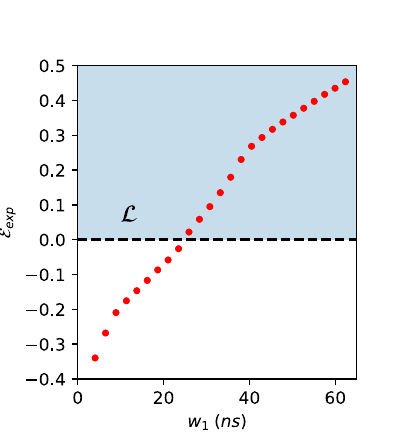
Fig. 9 | Robustness of the entropic technique to experimental noise. Values of the quantity E exp , as de fi ned in Eq. (8), as function of the two-fold coincidence window w 1 . If w 1 >25ns, due to the noise, the entropic witness isnot ableto detect nonclassicality, resulting in a strictly positive value of the quantity E exp . The left- most point corresponds to the result reported in subsection “ Bounding measure- ment dependence and violating an entropic inequality for the triangle network", i.e.,awindow w 1 ~4.1ns,theplotted errorbarsarecalculated throughMonteCarlo